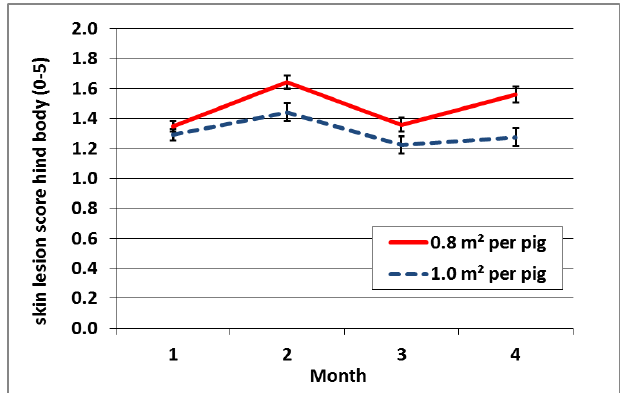
Figure 3. Mean skin lesion scores at the hind body part with SEM in error bars per month for high and low space allowance. Table 3. Mean tail length, lesions, and blood scores over time with SEM and p value; different superscripts within a row indicate a statistical difference ( p < 0.05).